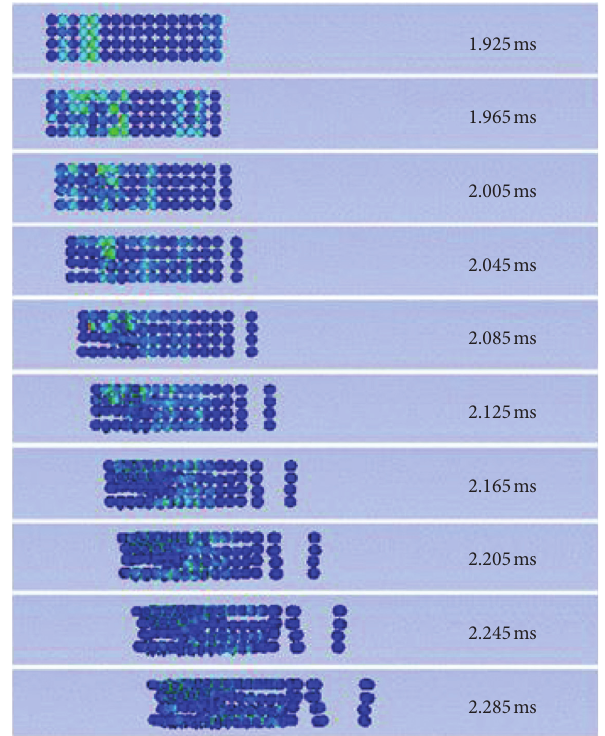
Figure 10: Simulated initial movement pattern of packed